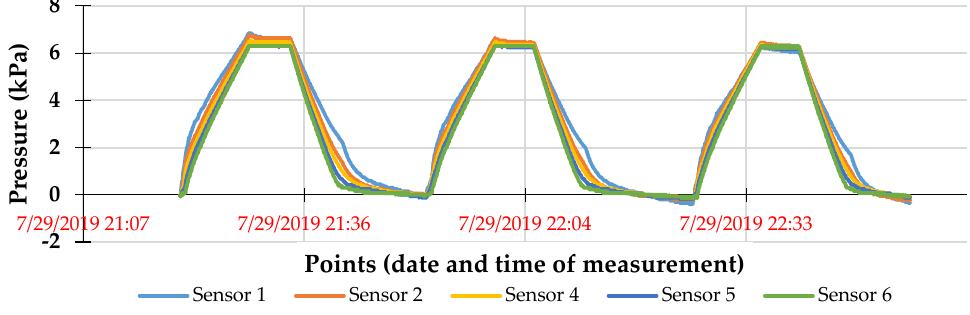
Figure A2. Calibration of the sensors of the total earth pressure (DMTY).